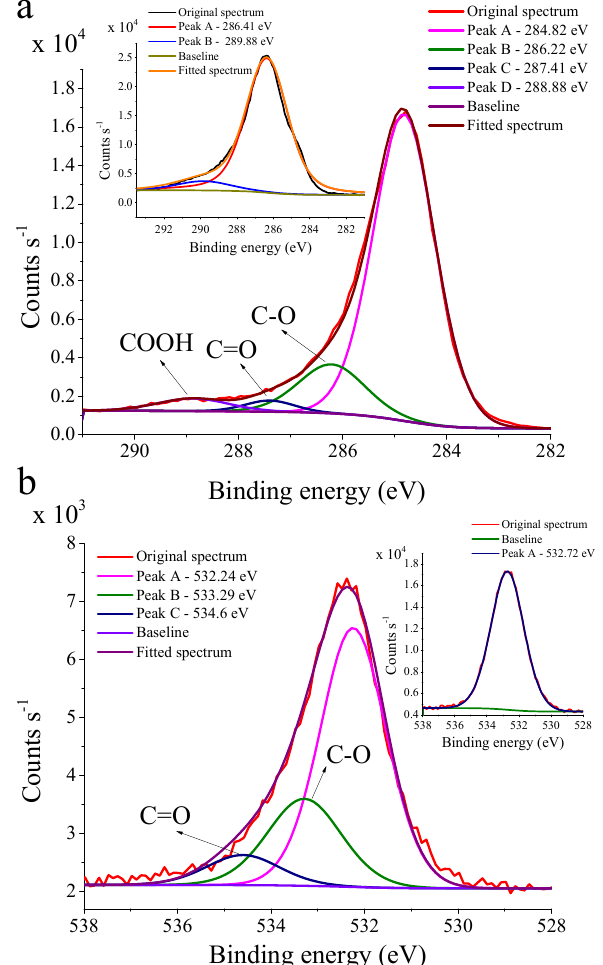
Figure 5. ( a ) C1s and ( b ) O1s spectra of carbon fiber sample with lignin coating, insets show the C1s ( a Inset) and O1s ( b Inset) spectra recorded on the clean carbon fiber surface before the functionalization procedure.